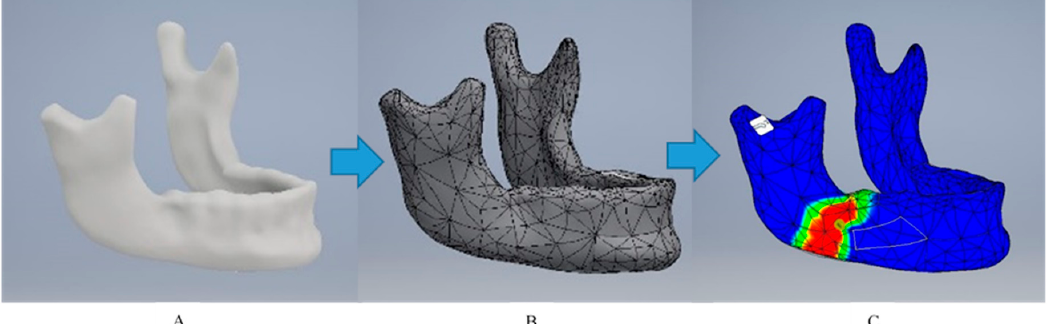
Figure 2. Obtaining a numerical model ( A ) is followed by its division into many simple finite elements that are connected at a common nodal point (discretization) ( B ). After each element is assigned appropriate material properties, the finite element analysis (FEA) of simulated forces at different regions of the numerical model can be conducted and the distributions of specific stresses and strains revealed ( C ).